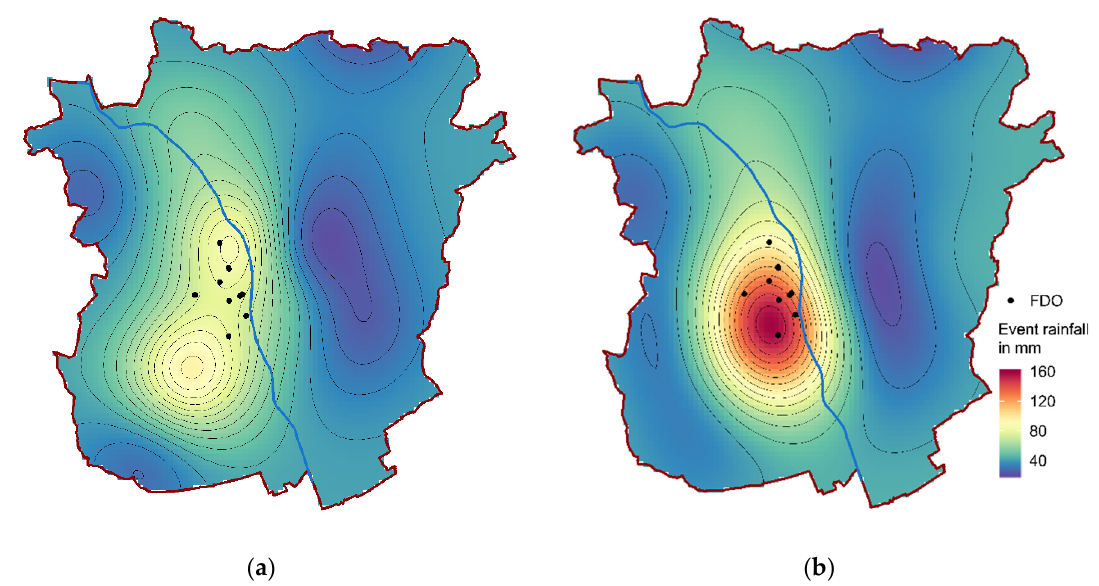
Figure 6. Interpolation of the storm from 16 April 2018 with a return period of 100+ years. The flooding locations are indicated by the logged flood related fire department operations (FDO): ( a ) with the rain gauges currently in the GCMN; ( b ) with the added information from a standard rain gauge used for daily reference values